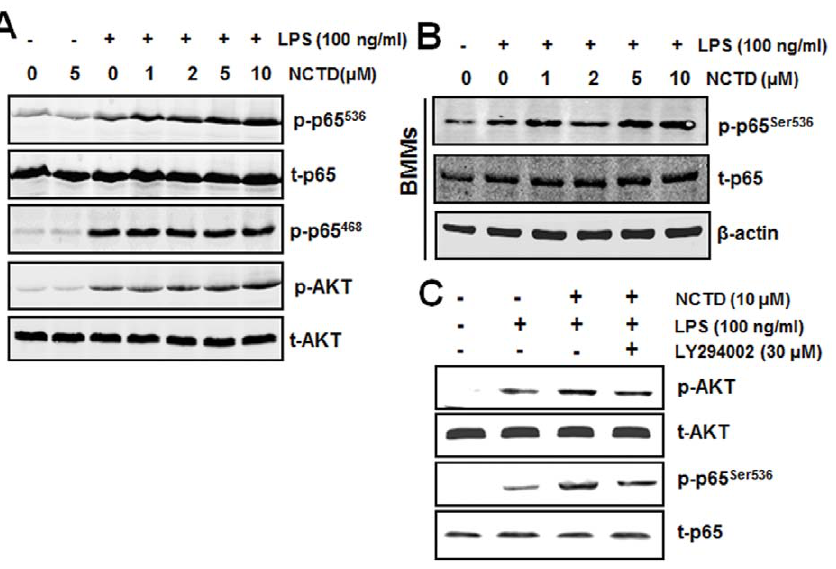
Figure 5. Regulation of NCTD on LPS induced p65 phosphorylation. A, p65 phosphorylation at Ser536 was up-regulated by NCTD in macrophages. RAW264.7 cells were treated with PBS (containing 0.1% DMSO), 5 m M NCTD without stimulation or 1–10 m M NCTD for 24 h and stimulated with 100 ng/ml LPS for different time. The levels of total proteins and their phosphorylated form in the cellular lysates were analyzed using Western blotting. B, NF- k B p65 phosphorylation was up-regulated by NCTD in BMMs. BMMs were treated by PBS (containing 0.1% DMSO) or 1– 10 m M NCTD and stimulated with 100 ng/ml LPS for different time. Total cell lysates obtained at 15 min after the activation by LPS and the levels of total p65 and its phosphorylated form in the cellular lysates were analyzed using western blotting. C, PI3K inhibitor LY294002 blocks phosphorylation of AKT and p65. After pretreated with NCTD for 24 h, RAW264.7 macrophages were treated with 30 m M LY294002 for 40 min and then stimulated with 100 ng/ml LPS for the indicated time periods. The phosphorylation of AKT and p65 were detected by Western blotting. Three independent experiments were performed.